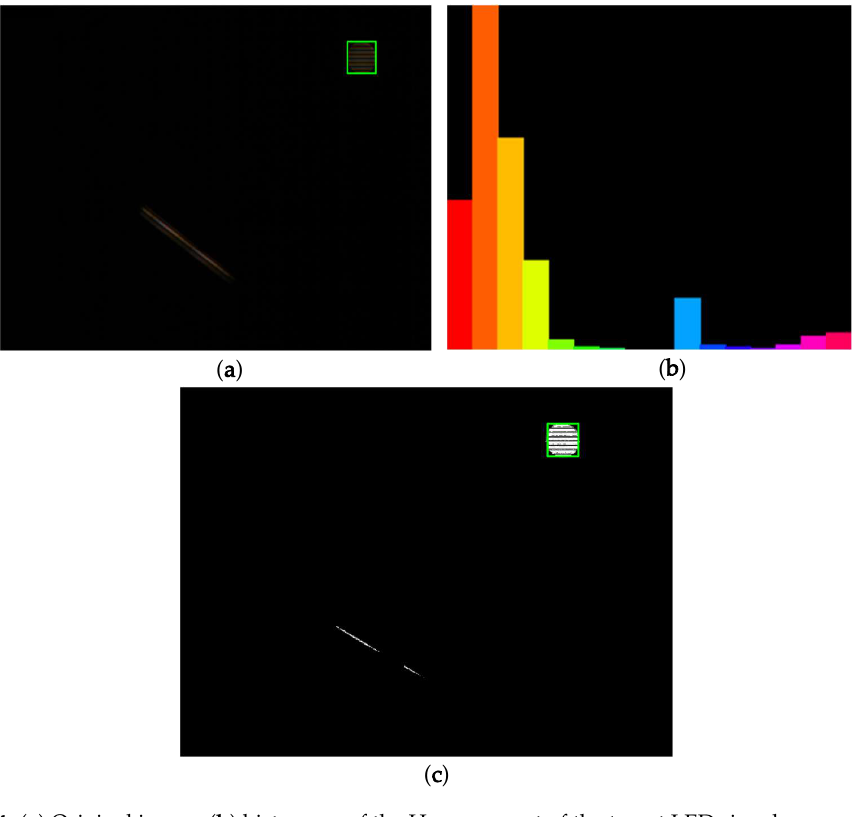
Figure 4. (a) Original image, (b) histogram of the H component of the target LED s ignal source, and Figure 4. ( a ) Original image, ( b ) histogram of the H component of the target LED signal source, and ( c ) (c) back-projection image, respectively. back-projection image,